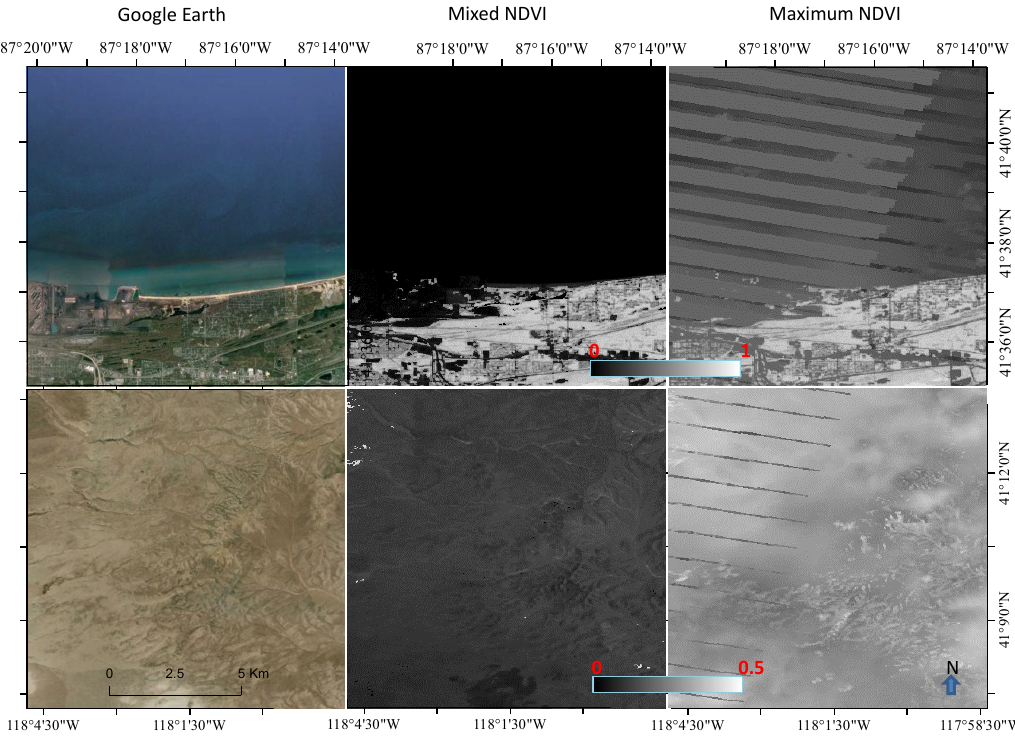
Figure 5. Nominal 2006 NDVI composites created with the Maximum NDVI criteria and the Mixed NDVI criteria over a water site ( upper row ) and a bare land site ( bottom row